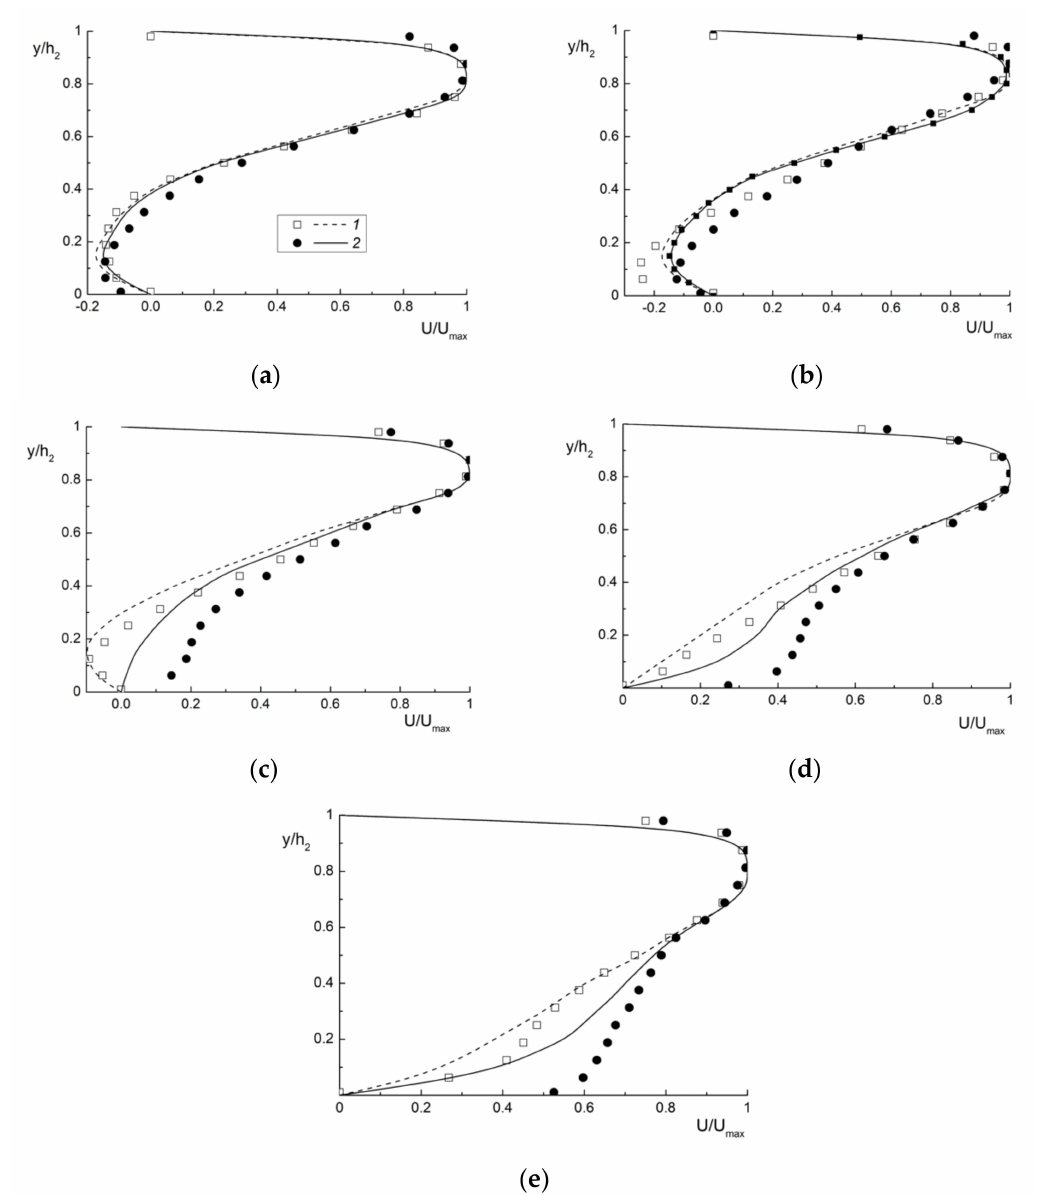
Figure 6. The transverse profiles of the carrier phase mean streamwise velocity along the duct length. Symbols and curves are the authors’ measurements and predictions respectively. Re H = 6600, ER = 2.5, β = 3%. 1—single-phase flow ( β = 0), 2— β = 3%. ( a )— x/H = 2, ( b )—4, ( c )—6, ( d )—8, ( e